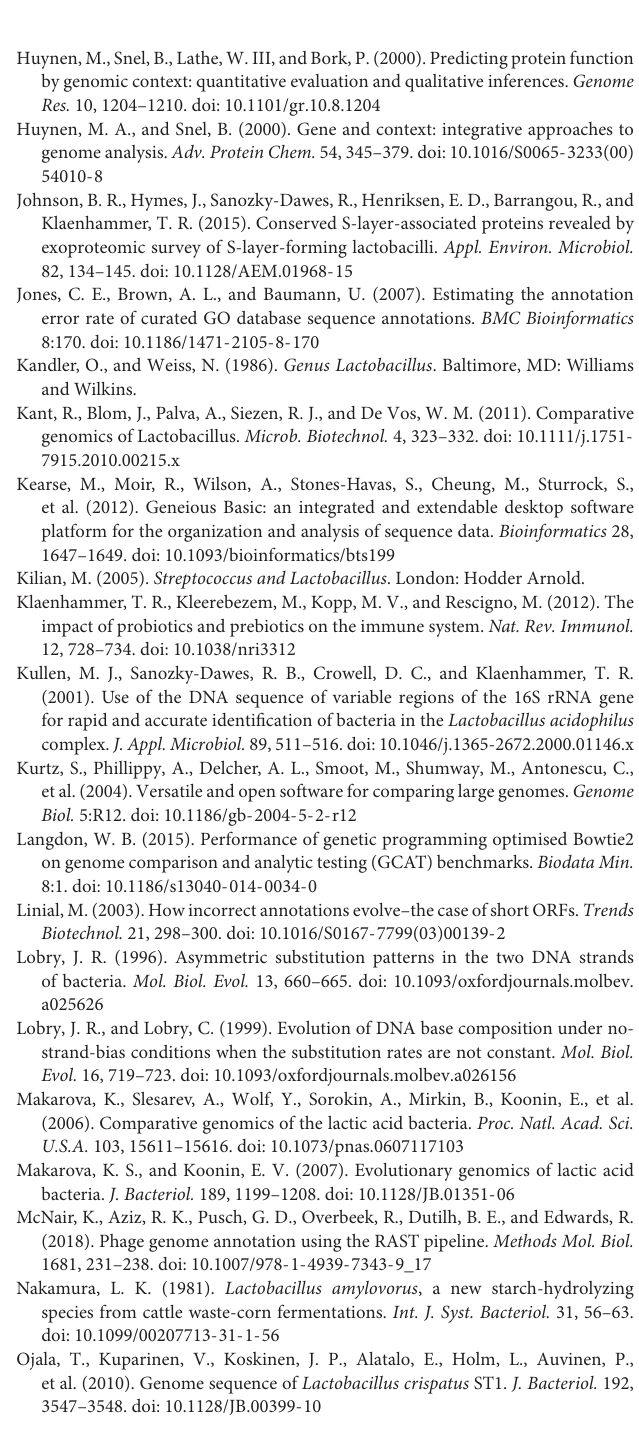
(colored bars) is shown for several characteristics, including gene length (in base pairs), codon adaptation index, GC content, and expression (measured by log 10 RPKM). TABLE S1 | All coding sequences from L. acidophilus complex. TABLE S2 | Core genome functional annotation. TABLE S3 | Gene presence-absence in pan